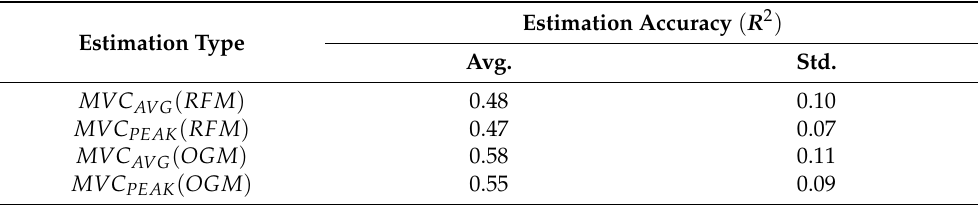
Table 8. The performance of the latest model for 20 times with model optimization (January 2022).